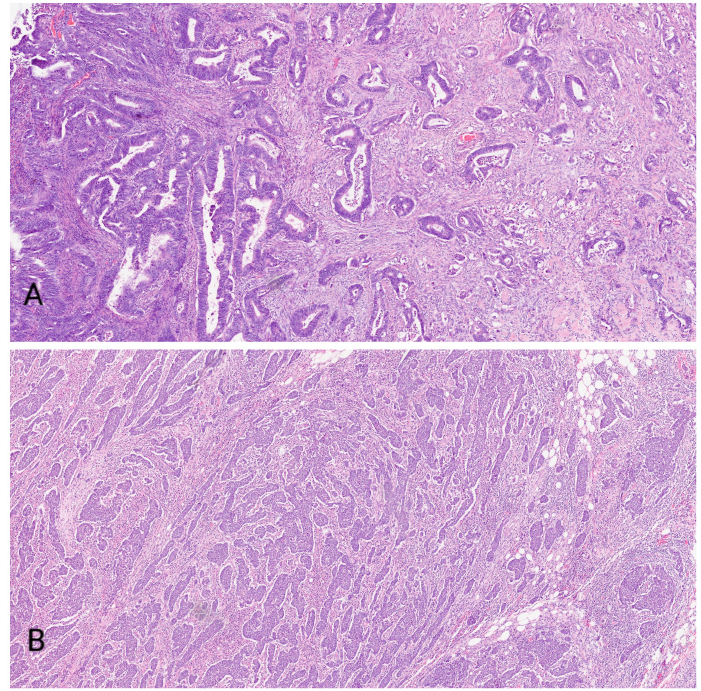
Figure 1. Figure shows low-grade ( A ) and high-grade ( B ) colorectal cancer.